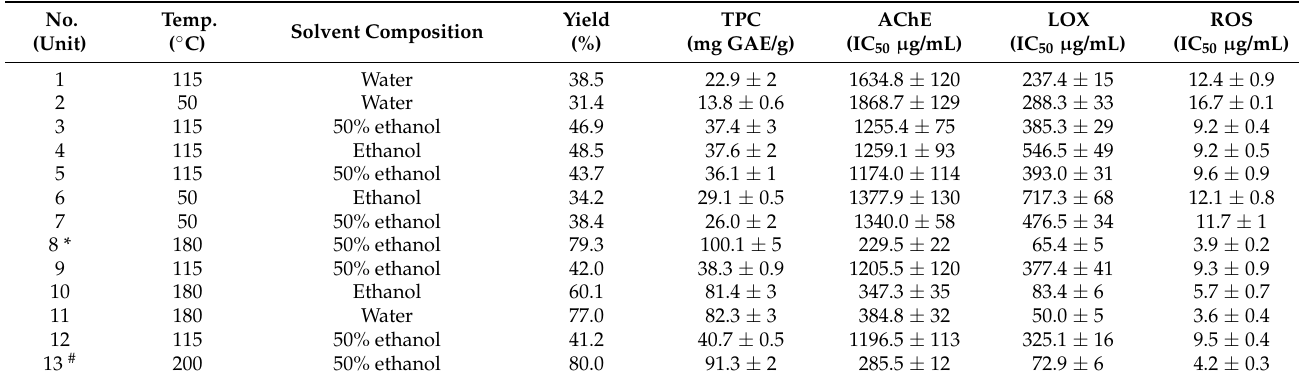
Table 2. Results observed in the response variables during the optimization of PLE conditions for thinned peach extraction.